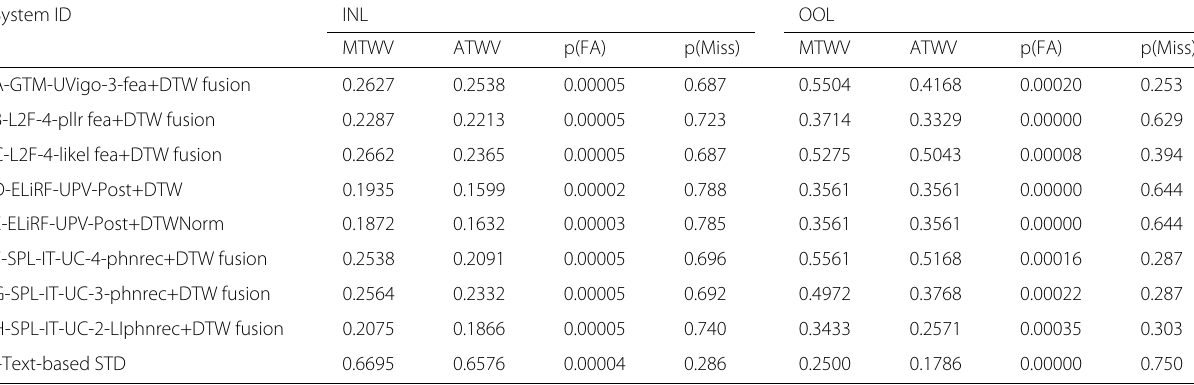
Table 16 System results of the ALBAYZIN QbE STD 2016 evaluation on the MAVIR test data for the in-language (INL) and the out-of-language queries